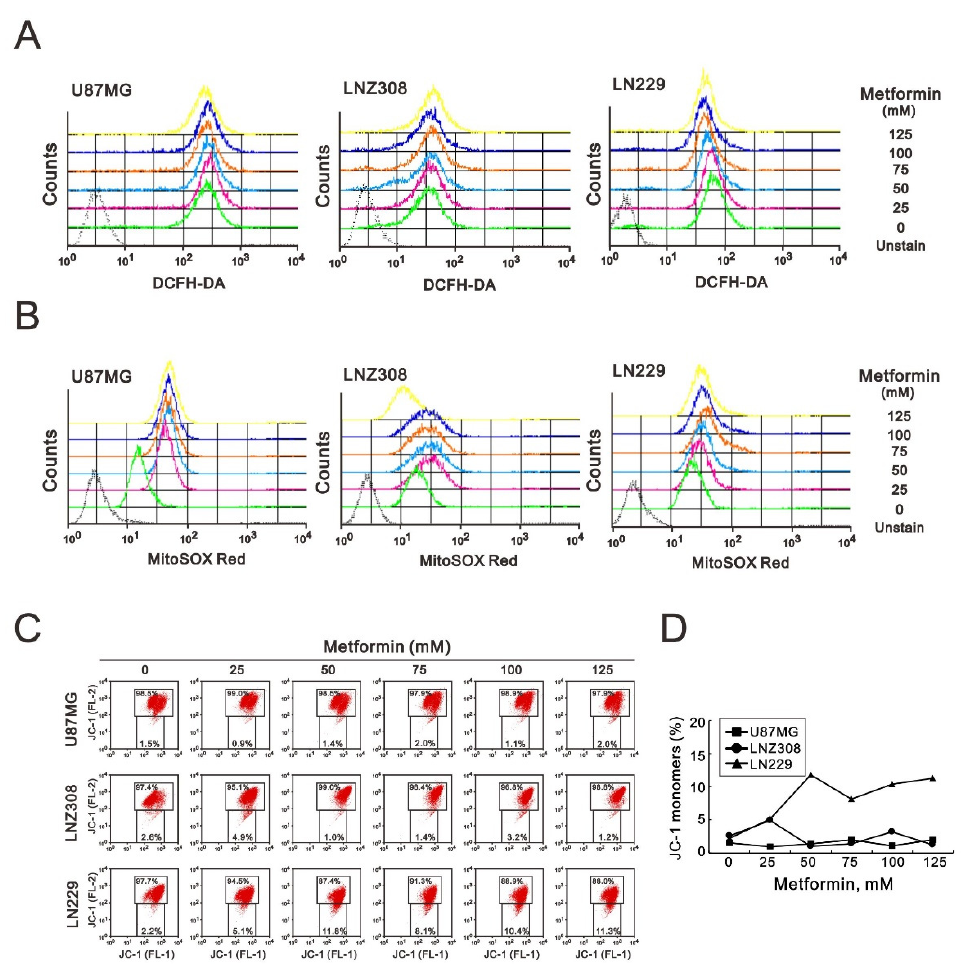
Figure 5. The effects of metformin on cytosolic ROS, mitochondrial ROS, and mitochondrial mem- brane potential in GBM cells. U87MG, LNZ308, and LN229 cells were treated with the indicated metformin concentrations. After 3 h, ( A ) the cytosolic ROS was measured with DCFH-DA, and ( B ) the mitochondrial ROS was measured with the MitoSOX Red kit using flow cytometry analysis. ( C ) U87MG, LNZ308, and LN229 cells were treated with the indicated metformin concentrations for 5 h. The integrity of the mitochondrial membrane potential was measured with JC-1 dye using flow cytometry analysis. Their quantification of monomer (FL-1, green fluorescence) form of the dye showed as ( D ).